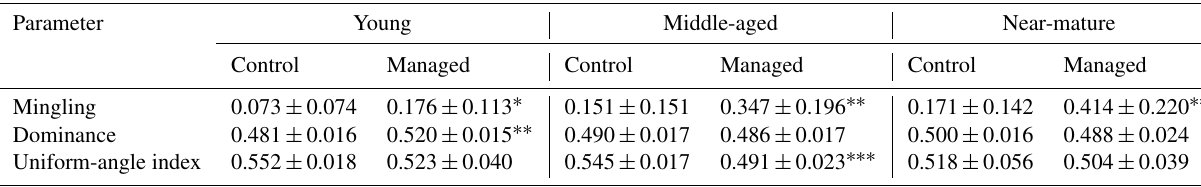
Table 3. t -test results of the univariate distribution of the spatial-structure parameters.